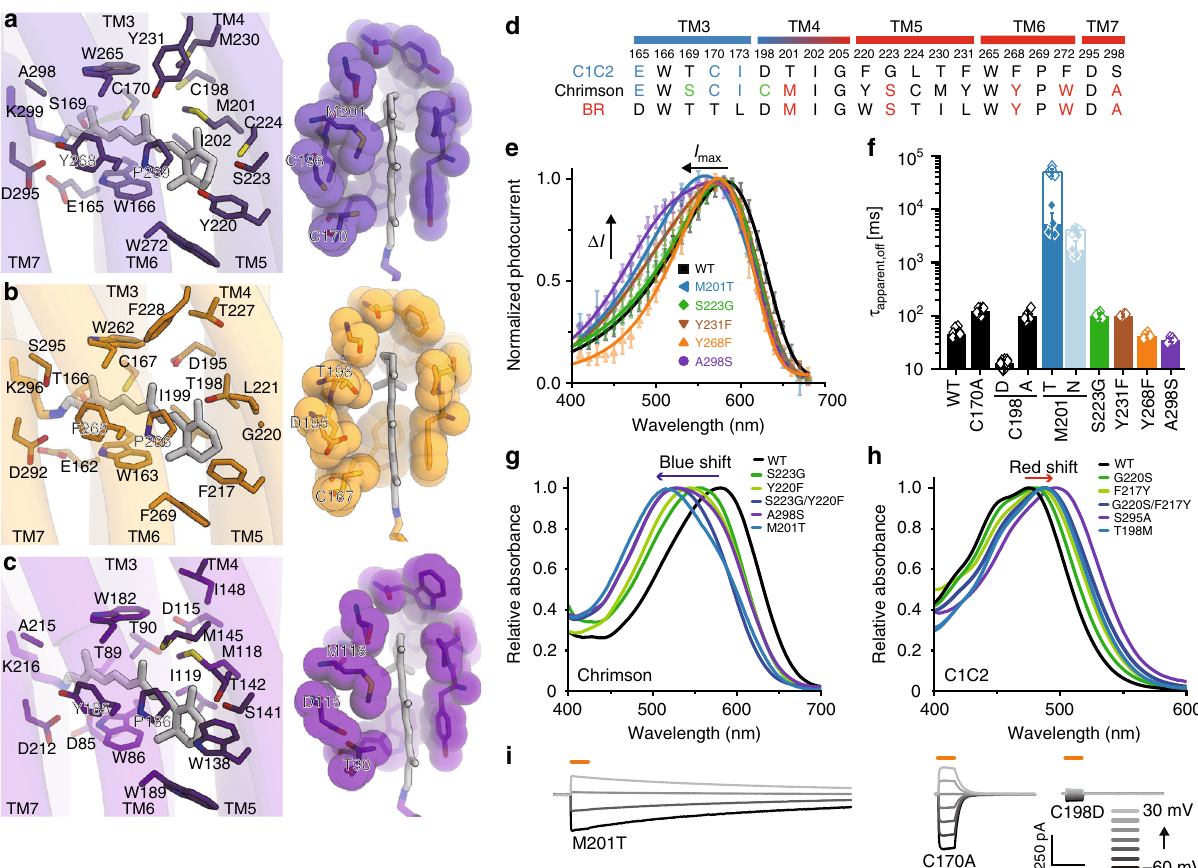
Fig. 5 Retinal binding pocket. a – c Structural comparisons of the retinal binding pockets of Chrimson ( a ), C1C2 ( b ), and BR ( c ). As the retinal pockets of C1C2 and Cr ChR2 are quite similar, C1C2 is shown as the representative structure of the Cr ChRs. Residues constituting retinal binding pocket are shown in sticks (left panels). CPK model representations shows different association in the retinal binding pocket (right panels). d Sequence comparison of Chrimson with C1C2 and BR. The residue numbering of Chrimson is indicated above the sequence. Chrimson resembles BR in TM5 – 7, surrounding the polyene chain and β -ionone ring, while it resembles C1C2 (or Cr ChRs) in TM3, located near the ion-conducting pore. Residues common to BR and C1C2 are depicted in cyan and red, respectively. e Mutations that affect action spectrum. Normalized peak photocurrents after 10 ms excitation at different wavelengths of equal photon count (Mean ± SD; n = 5 – 8; symmetric 110 mM NaCl, pH e,i 7.2 and − 60 mV) are shown. f Apparent photocurrent off-kinetics of retinal binding pocket mutants ( τ apparent off ; Mean ± SD; n = 5 – 11; symmetric 110 mM NaCl, pH e,i 7.2 and − 60 mV). Empty columns for M201T and M201N represent conductance measurements by short 20 ms voltage pulses to − 60 mV at 0.2 and 0.5 Hz, respectively, and at a holding potential of 0 mV in order to reduce kinetic artefacts imposed by intracellular acidi fi cation due to continuous proton in fl ux as previously reported 22 (Mean ± SD; n = 5 – 6). g , h Absorption spectra of wild type and mutant Chrimson ( g ) and C1C2 ( h ). Mutations at the same positions are indicated by the same color codes. Peak shifts caused by mutation is indicated by blue or red arrow. i Representative photocurrent traces of the M201T, C170A, and C198D mutants, measured at different voltages in symmetric 110 mM NaCl, pH e,i 7.2 and illuminated with 580 nm light (orange